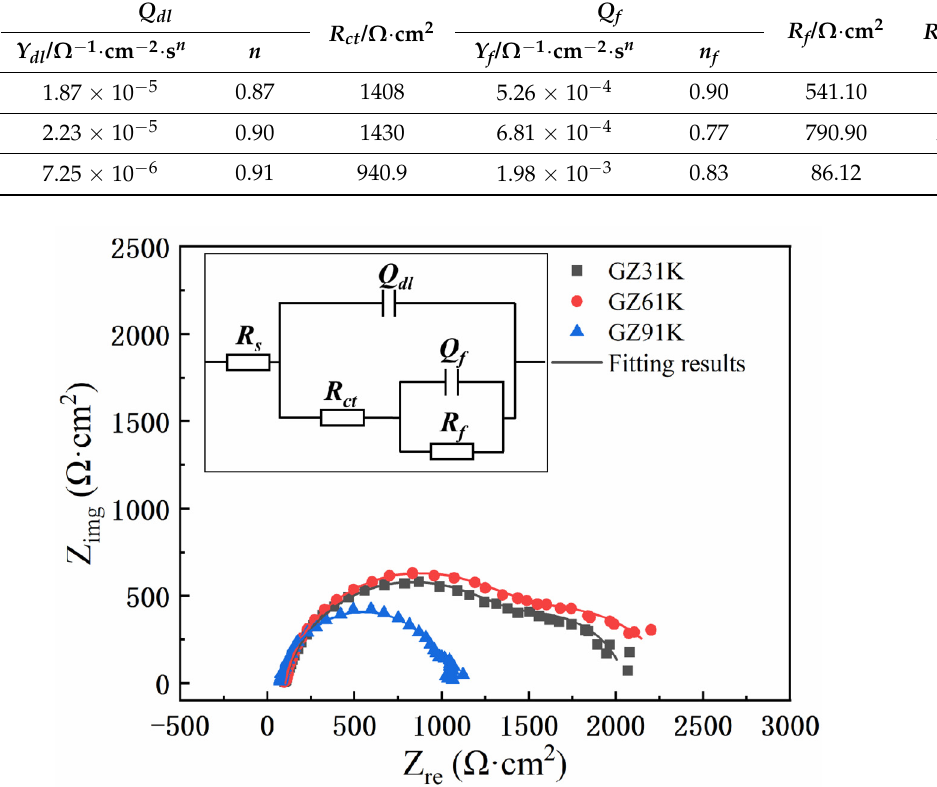
Figure 5. Nyquist plots of Mg alloys in SBF solution and their equivalent circuit model.